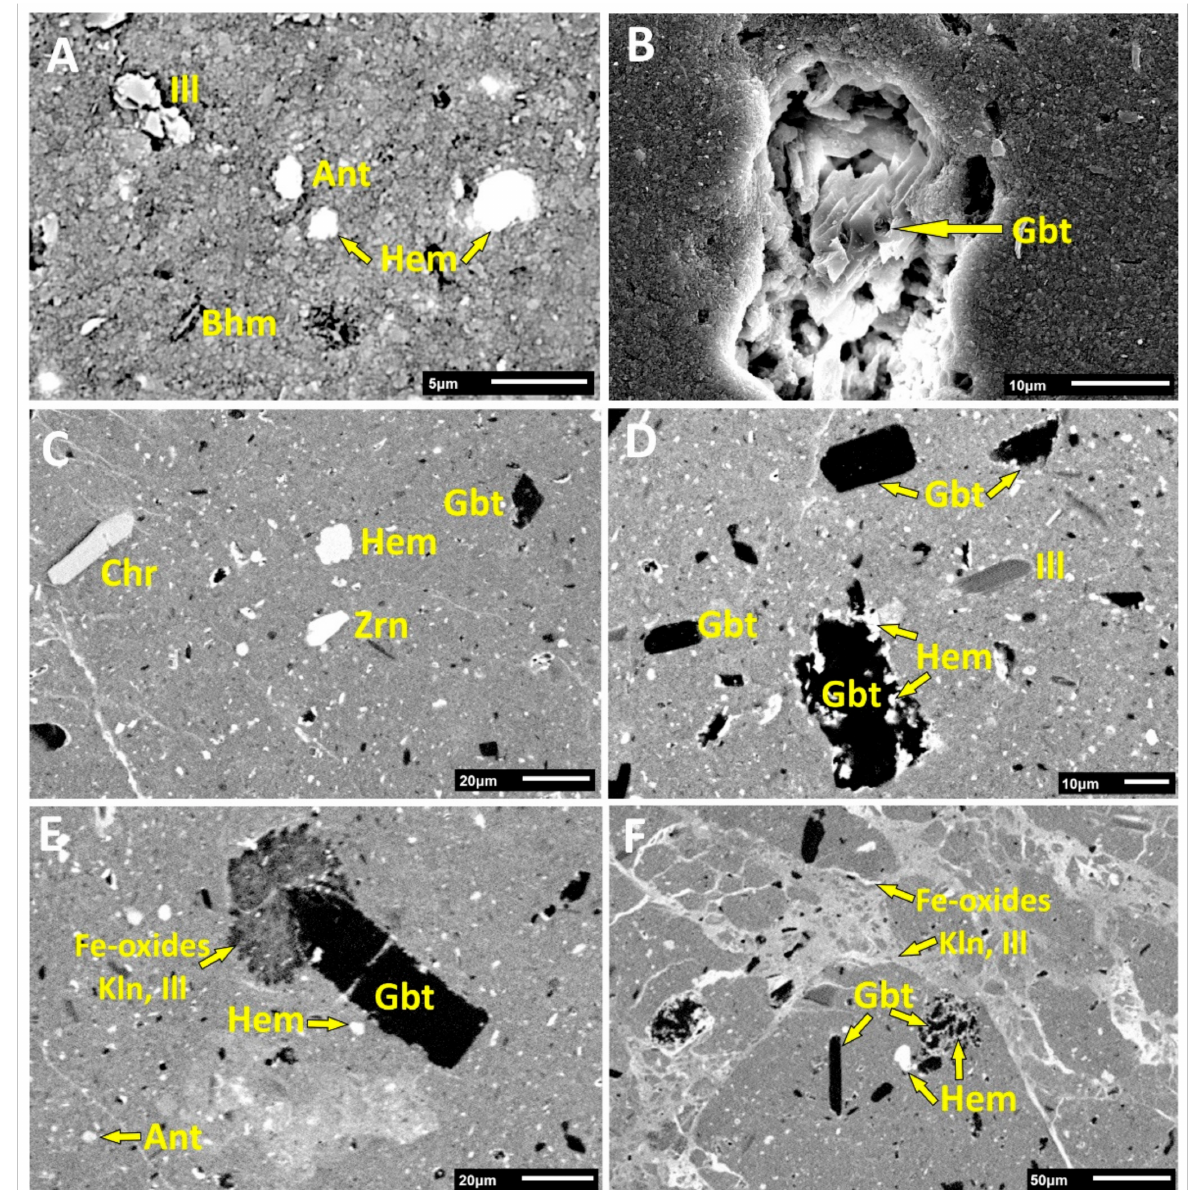
Figure 4. SEM micrographs presenting mineral content (Gbt–gibbsite; Bhm–böhmite; Hem–hematite; Ant–anatase; Zrn– zircon; Chr–chromite; Kln–kaolinite; Ill–illite), and textural features of the bauxite matrix: ( A )—individual mineral grains of böhmite, hematite, anatase, and illite dispersed in the matrix of sample TOS-2; ( B )—gibbsite in a vug of TOS-2 presenting dissolution figures with likely occurrence of finely sprinkled böhmite; ( C )—individual mineral grains of gibbsite, hematite, zircon, and chromite dispersed in the matrix of sample TOS-3; ( D )—gibbsite grains in TOS-3, which are occasionally covered and intruded with hematite on sites of etching or mechanical abrasion (the largest grain), with the illite grain observed on right; ( E )—dispersed individual grains of hematite and anatase, and a large euhedral gibbsite grain in contact with an aggregate of Fe-oxides, kaolinite, and illite in TOS-3; ( F )—preserved almost euhedral grains of gibbsite and fragmented gibbsite grains covered and intruded by hematite; veinlets significantly intersecting the sample are filled with Fe-oxides, kaolinite, and illite in